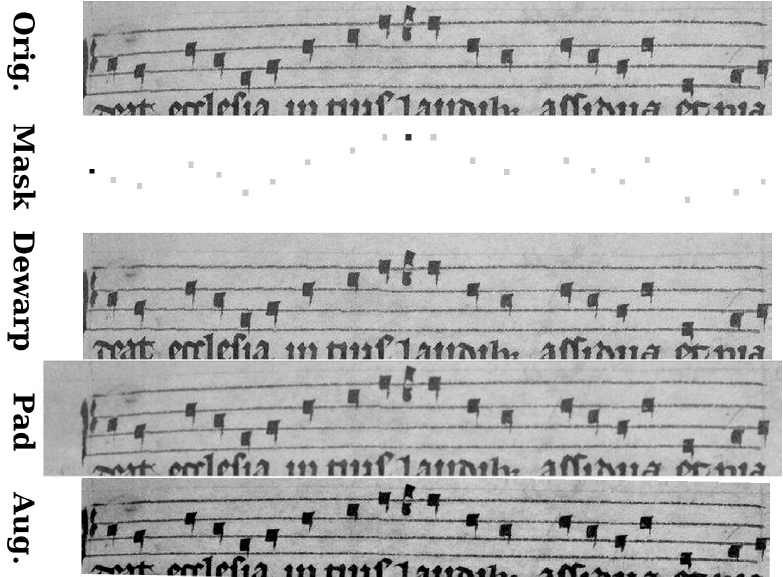
Figure 7. The first line shows the cut off original input image. The next one is the target mask for the FCN in which notes and clefs are marked. The next three lines show the dewarped, padded and an augmented version of the original